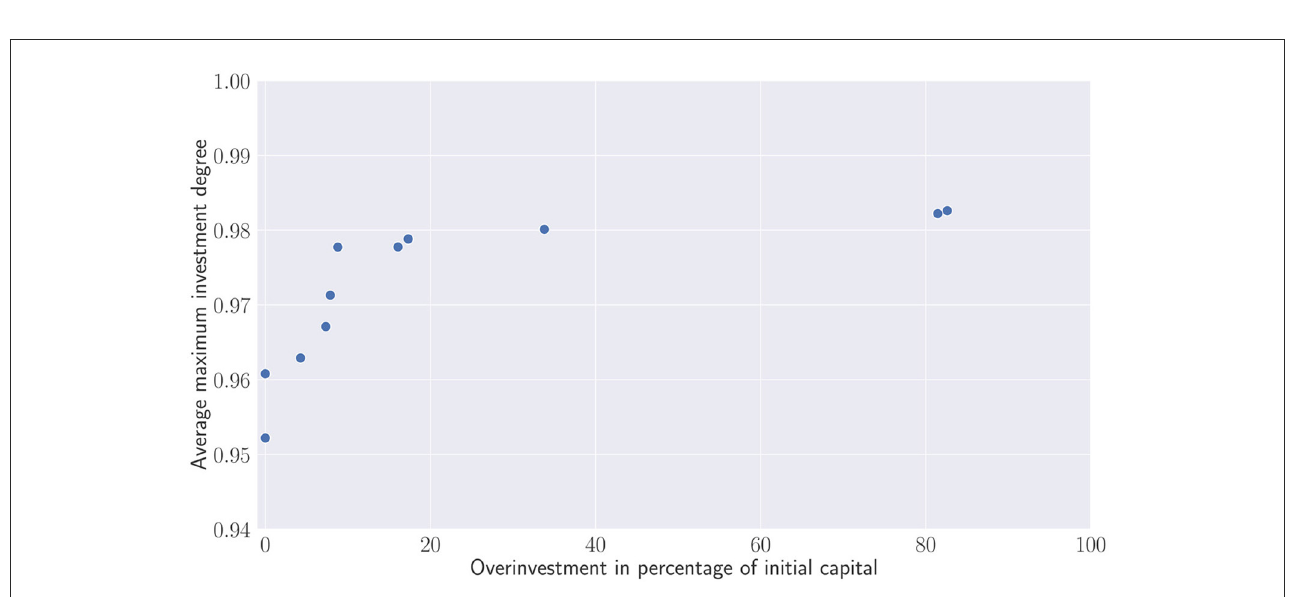
FIGURE10 Pareto set of recommitment strategies. Average maximum investment degree V.S.